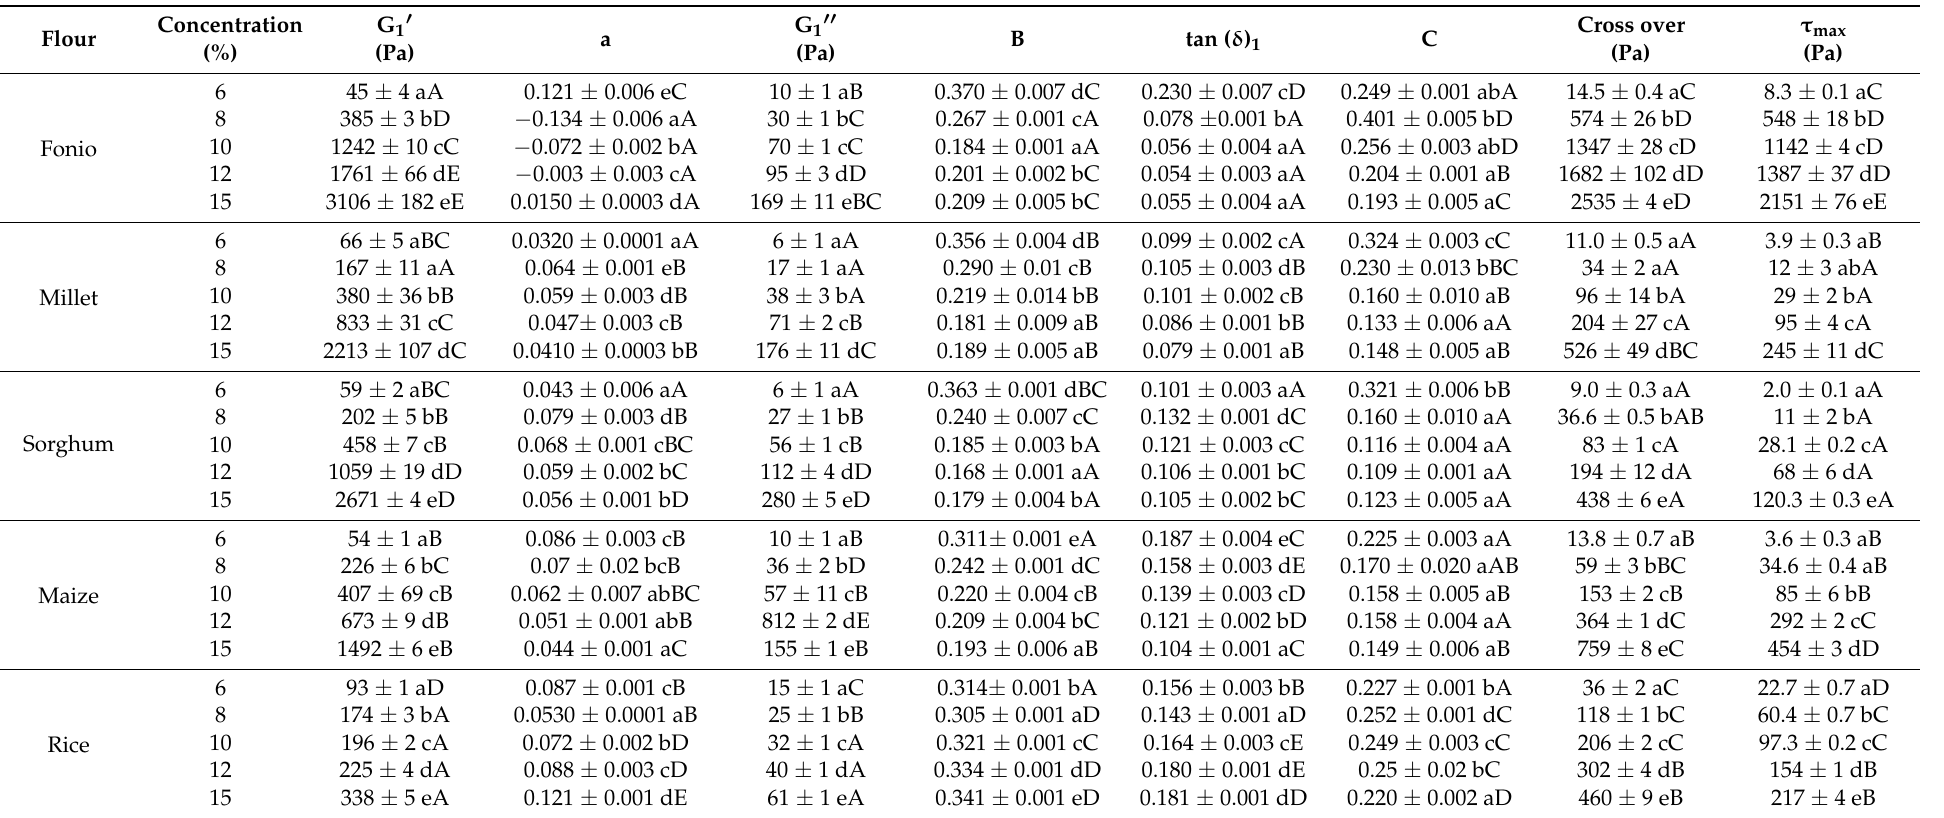
Table 3. Rheological properties of fonio, millet, sorghum, maize, and rice flour gels at different